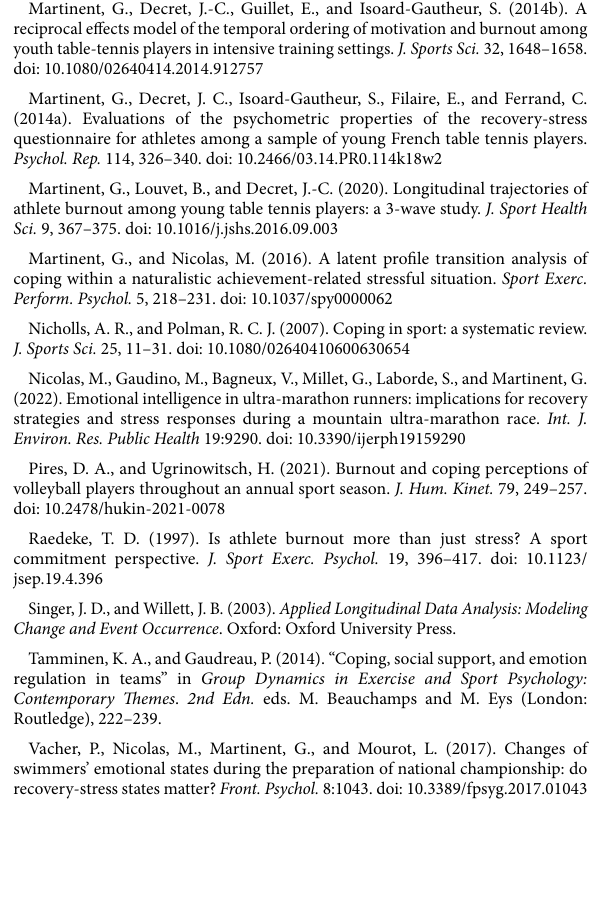
youth table-tennis players in intensive training settings. J. Sports Sci. 32, 1648–1658. doi: